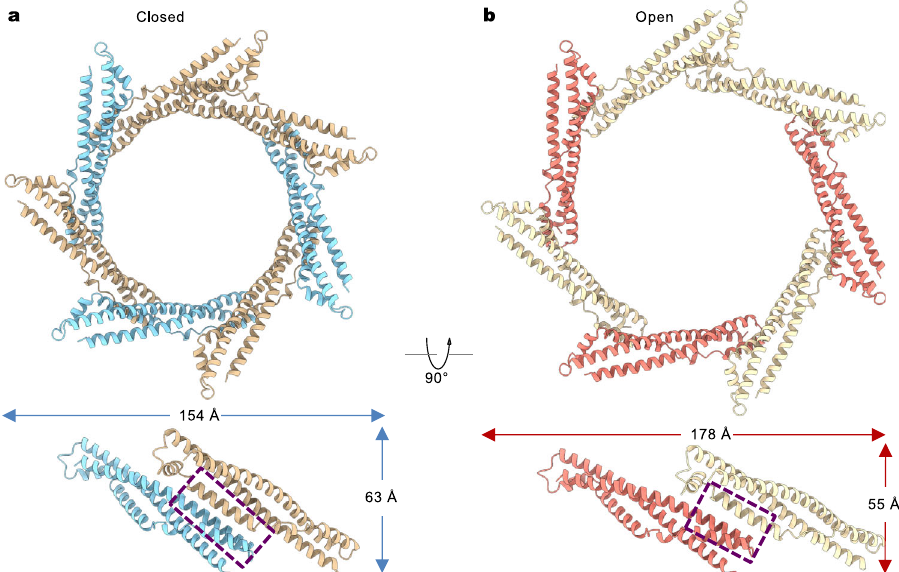
Fig. 4 | Periplasmic gating ring. a , b Structures of the PD in the closed ( a ) and open ( b ) states. The overall dimensions and the helix-packing interactions at the inter- subunit interfaces are